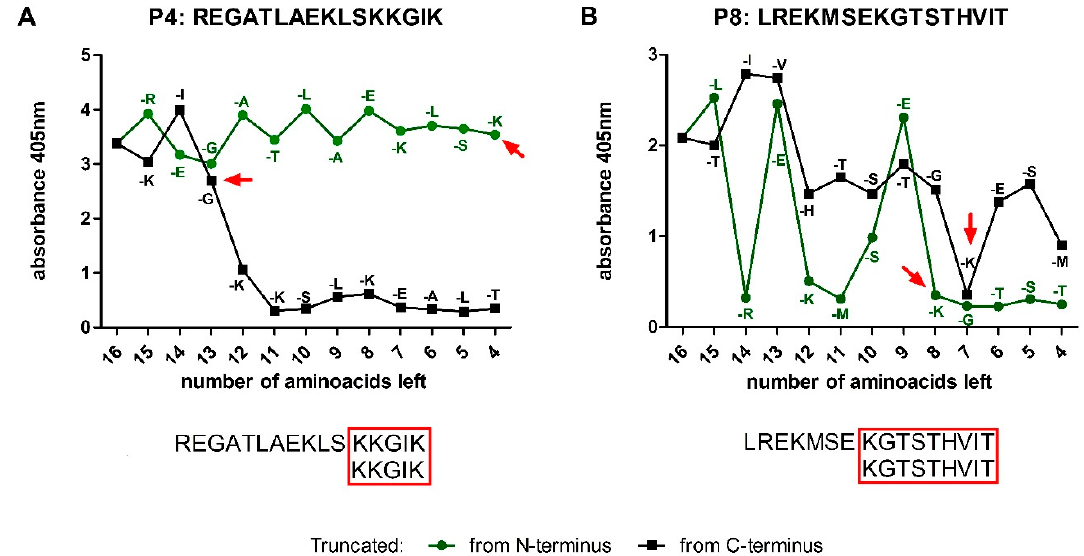
Figure 4. Results of ELISA with truncated from N- and C-terminus peptides mapped with the use of CDI patients’ sera (dilution 1:1000), detected with anti-human IgG secondary antibodies conjugated with AP and colorimetric reaction was developed with AP Yellow Substrate. Red arrows indicate amino acids which absence caused a strong decrease in immunoreactivity. ( A ) The minimal epitope found for P4 ( 131 KKGIK 135 ); ( B ) the minimal epitope for P8 ( 184 KGTSTHVIT 192 ).